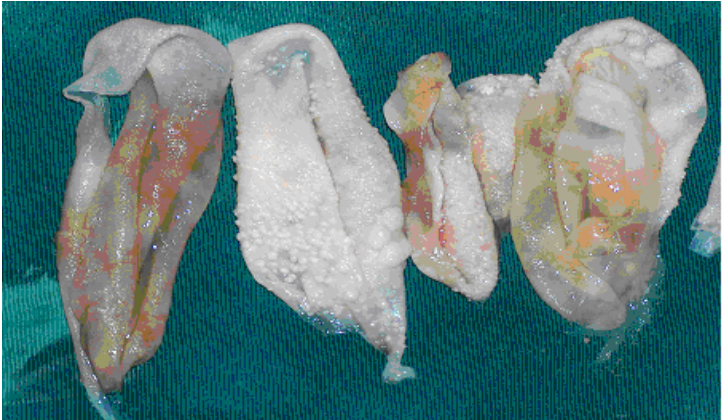
FIGURE 5. Germinative membranes belong to hydatid